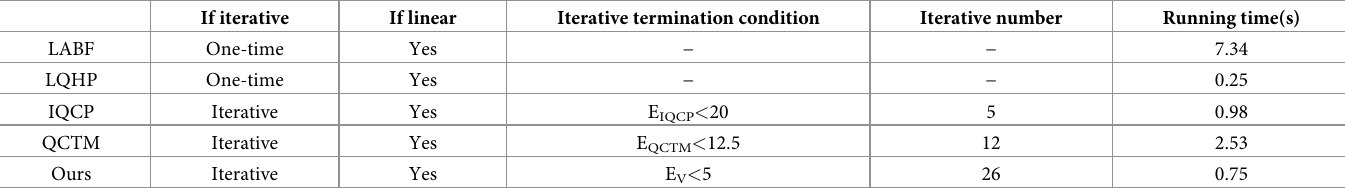
Table 1. Properties of the methods referring experiments on beetle.